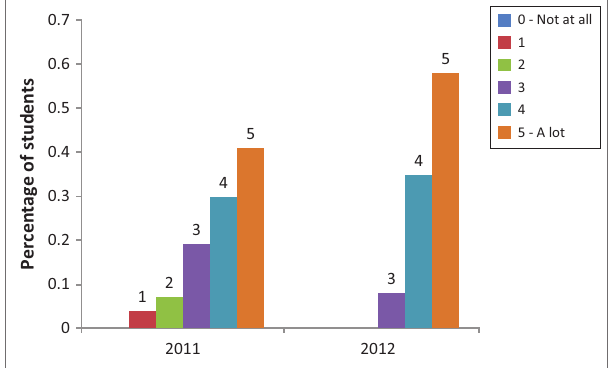
FIGURE 3: Students’ responses to the question ‘To what extent have you enjoyed journal